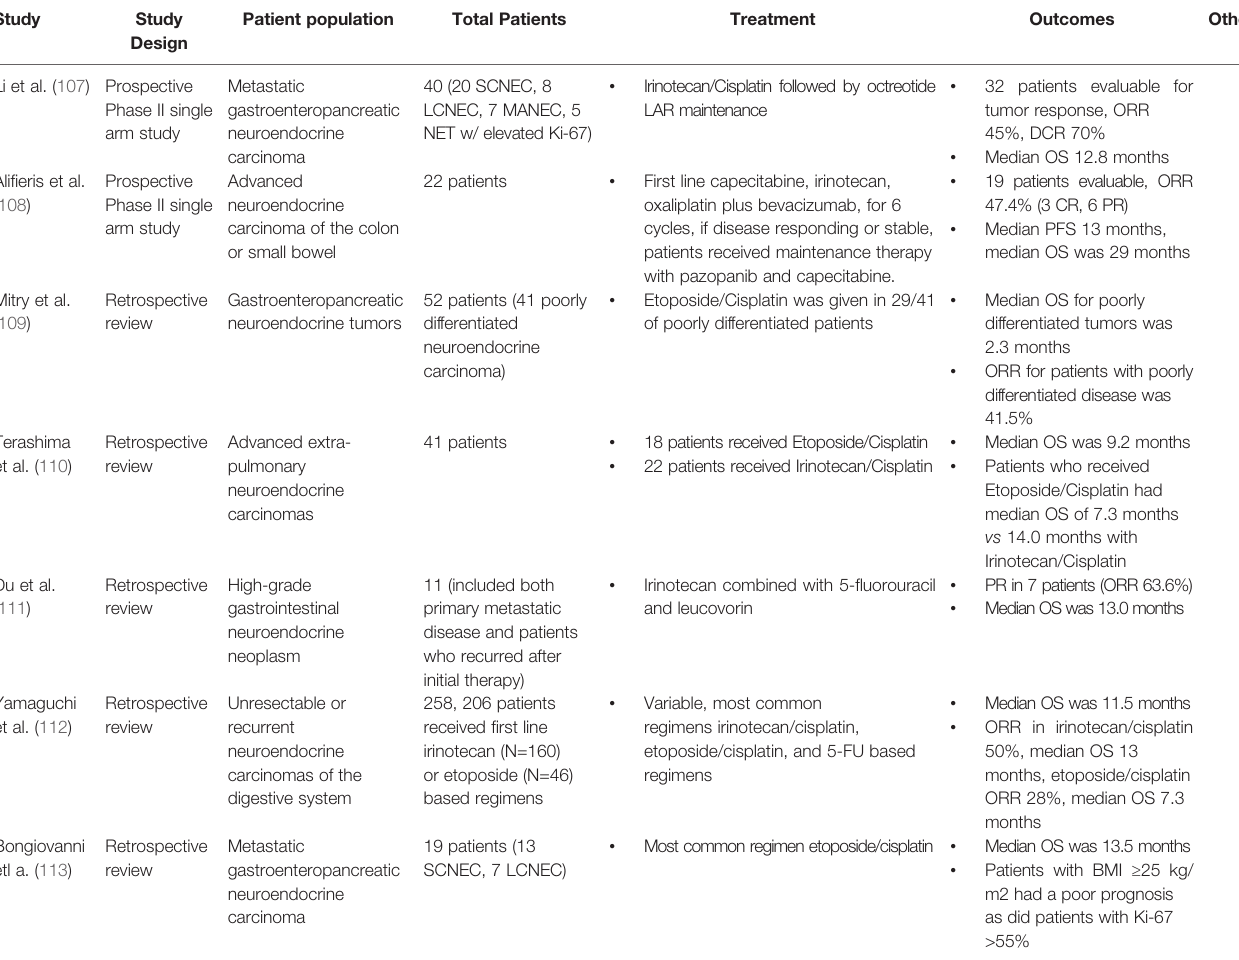
TABLE 8 | First Line Therapy in Metastatic Extra-Pulmonary LCNEC (most studies report outcomes for cohorts with combined SCNEC and